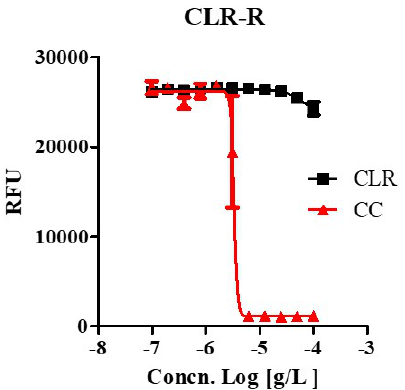
Figure 3. The activity of CC against clarithromycin-resistant M. abscessus mutants. Clarithromycin- resistant M. abscessus mutants ( M. abscessus CLR-R) were tested for their ability to grow in Mueller- Hinton medium when treated with 100 ug/mL to 0.097 ug/mL of clarithromycin (CLR) and CC. Dose-response curves of M. abscessus CLR-R mutant (Left panel). The experiments were carried out with three biological replicates and expressed as the mean ± SEM for each concentration. This result was made from a representative experiment.